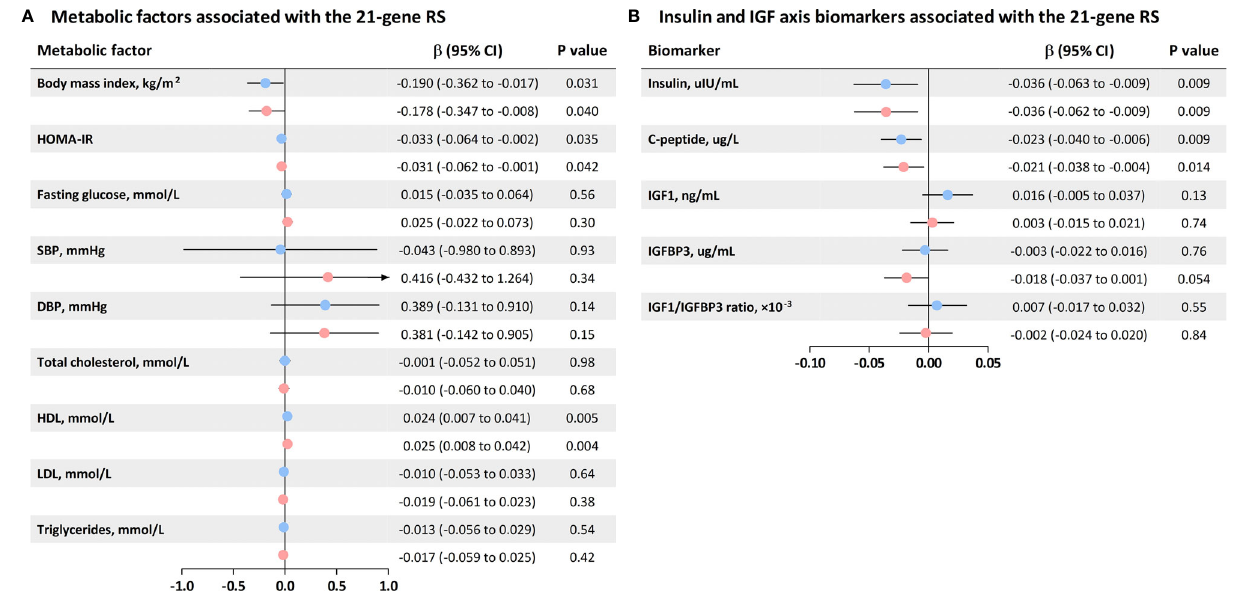
FIGURE 2 | Associations of the 21-gene RS with metabolic factors and insulin and the IGF axis biomarkers. (A) Levels of metabolic factors associated with each 10-unit increase in the 21-gene RS; (B) Concentrations of insulin and IGF axis biomarkers associated with each 10-unit increase in the 21-gene RS. Blue squares represent unadjusted b estimates, and pink squares indicate b estimates with adjustment for age and postmenopausal status (yes, no). Concentrations of HOMA-IR, IGF1, IGFBP3, IGF1/IGFBP3 ratio, insulin, and C-peptide were log transformed to improve the normality of their